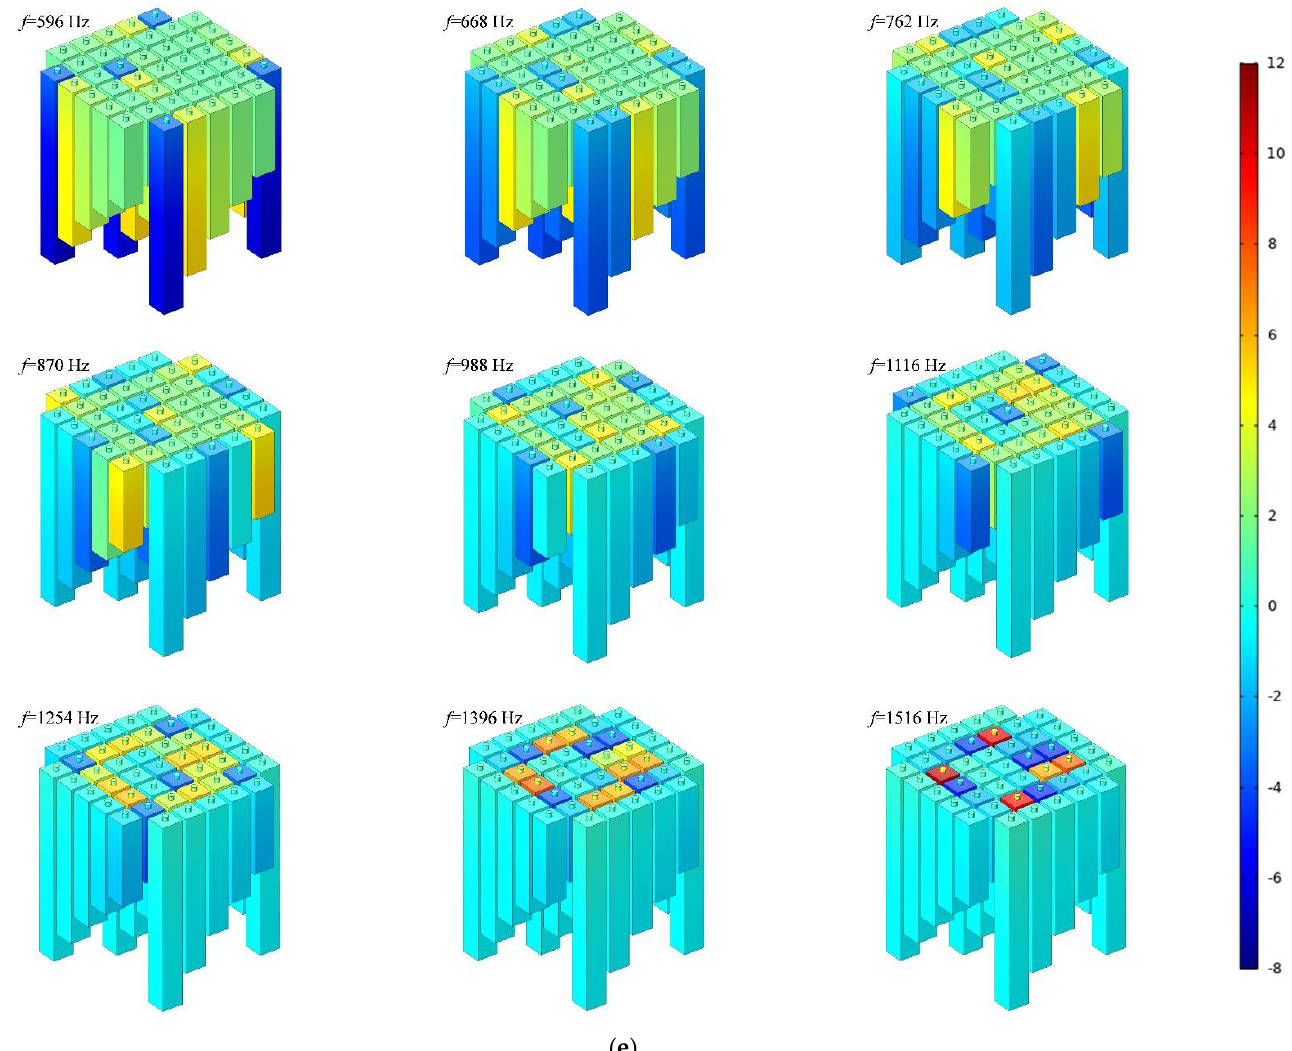
Figure 12. A finite element simulation of the APH-AM. ( a ) The whole 3D structural model; ( b ) the whole gridded model; ( c ) the gridded model of APH-AM; ( d ) distributions of acoustic pressure for the target with all sound absorption coefficients above 0.9; ( e ) distributions of acoustic pressure for the target with all sound absorption coefficients above 0.85.